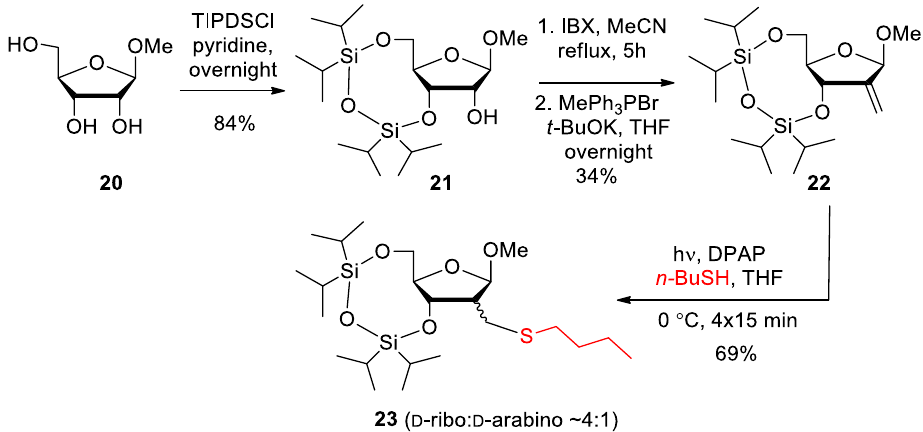
Scheme 3. Synthesis of reference compound 23 from methyl β - D -ribofuranoside. TIPDSCl: